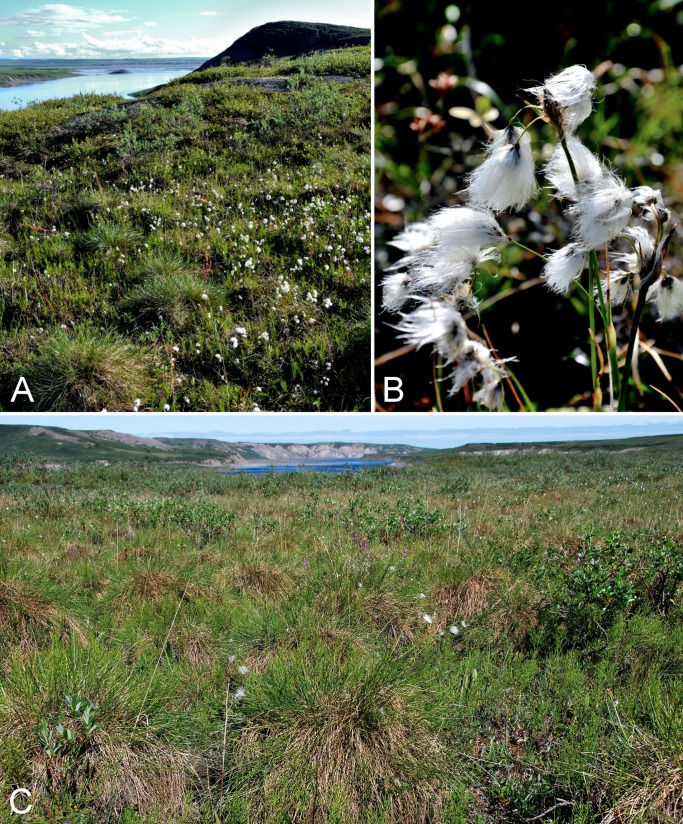
Eriophorum triste and Eriophorum vaginatum subsp. vaginatum.Eriophorum triste: (A) habitat, Saarela et al. 4087. (B) Inflorescence, Saarela et al. 4087. Eriophorum vaginatum subsp. vaginatum: (C) habitat, Saarela et al. 4055. Photographs by P. C. Sokoloff (A, B) and J. M. Saarela (C).